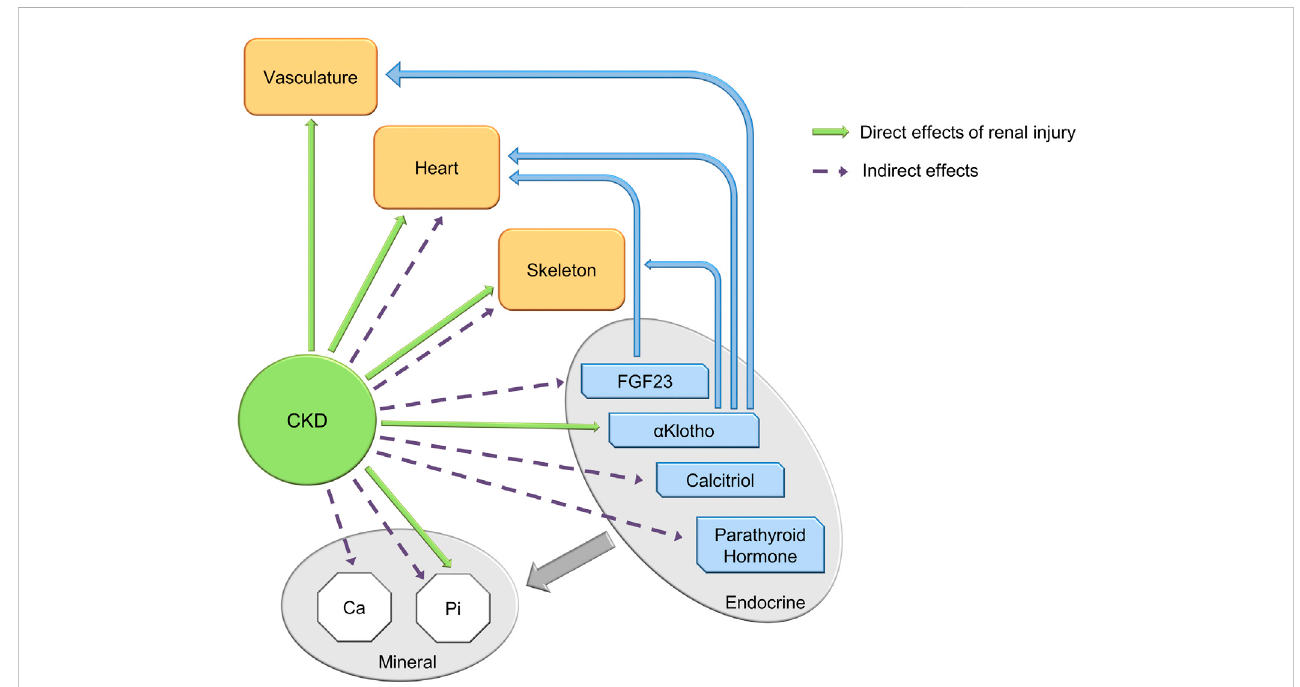
FIGURE 1 The components of the CKD-MBD — 3 organ dysfunctions, 4 endocrine factors and 2 mineral metabolism dysfunctions. Green arrows show direct effects of renal injury/repair on individual syndrome components, dotted arrows indirect effects. Thick gray arrow indicates that each of the endocrine components regulate mineral homeostasis. Blue arrows show effects of FGF23 and α klotho on organ dysfunction.